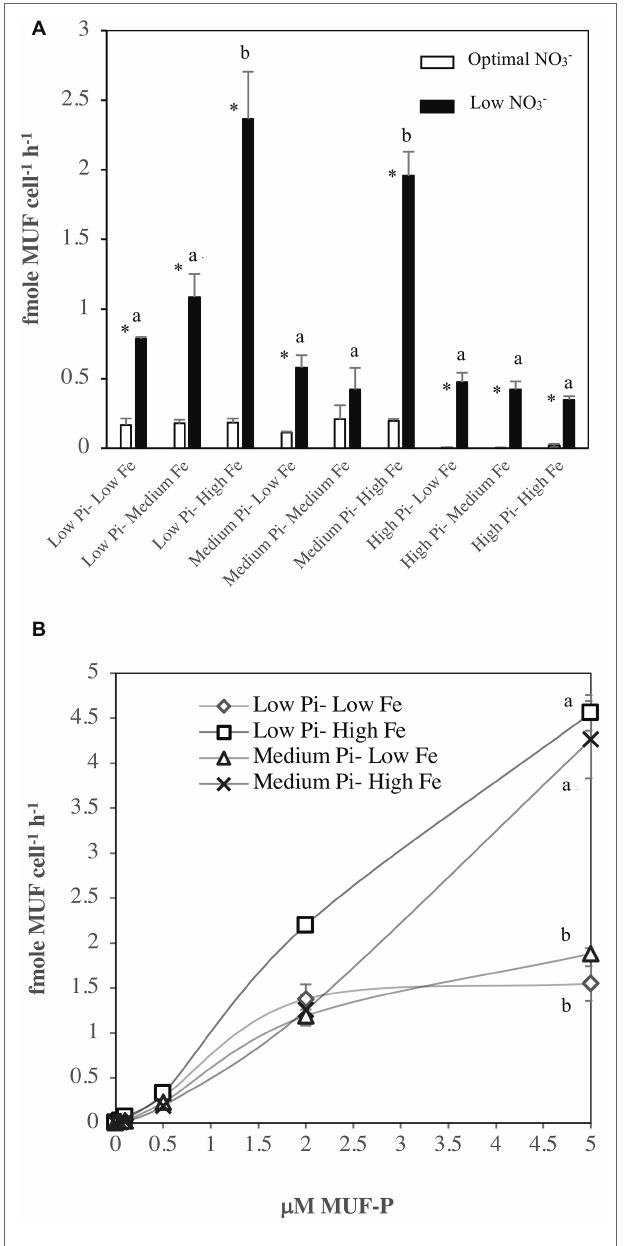
FIGURE 5 | Rates of alkaline phosphatase activity (APA, fmole MUF cell −1 h −1 ) in Halothece sp. PCC 7418 under 3 NO - starvation conditions compared with the optimal 3 NO - treatments under (A) treatment conditions: [Low 3 4 PO - –Low Fe], [Low 3 4 PO - –High Fe], and [High 3 4 PO - –High Fe] and (B) under re-inoculum of nutrients in treatment conditions: [Low 3 4 PO - –Low Fe, + 3 4 PO - + Fe + 3 NO - ] and [Low 3 4 PO - –Low Fe + 3 4 PO - + Fe]. 3 4 PO - is represented as Pi. Values are the mean, and the error bar is the spanning range between the duplicate optimum concentration of PO 43 - , Fe, and/or NO 3 - resulted in reduced APA rates particularly under the initial NO 3 - starvation conditions ( Figure 5B ).